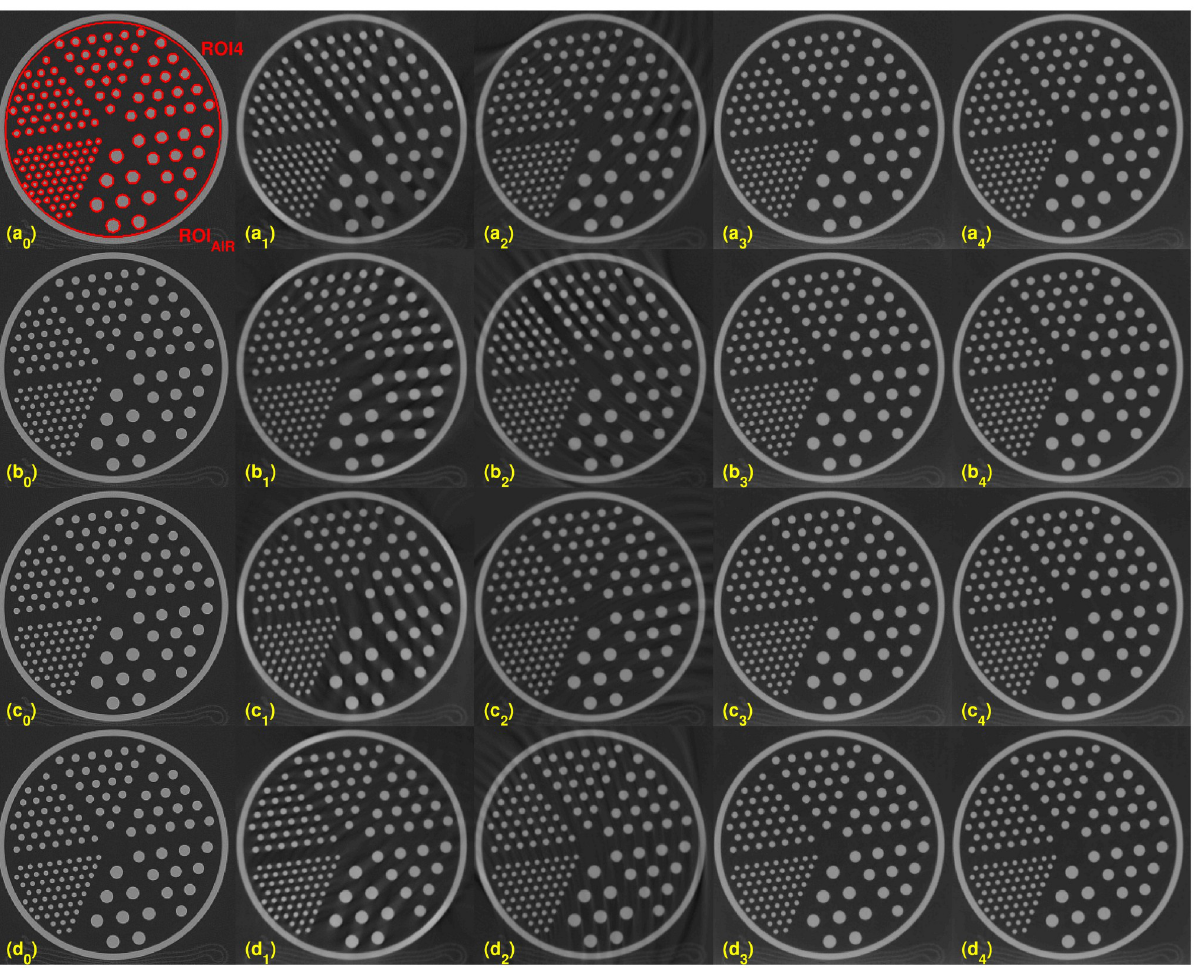
Fig 2. Comparison of the reconstruction algorithms with varying kVs on the 50-th slice. ROI4 is the set of the interiors of the small red circles. ROI AIR is defined as the air part inside the phantom on slice 50-th. Each row has reconstructed images at different kVs, (a j ): 80kV, (b j ): 100kV, (c j ): 120kV, and (d ): 140 kV, for all j = 0 ��� 4. Each column has reconstructed images from different reconstruction algorithms: (X 0 ): scanner, (X 1 ): FDK, j (X 2 ): Katsevich, (X 3 ): TV, and (X 4 ): TF for all letters X = a, b, c or